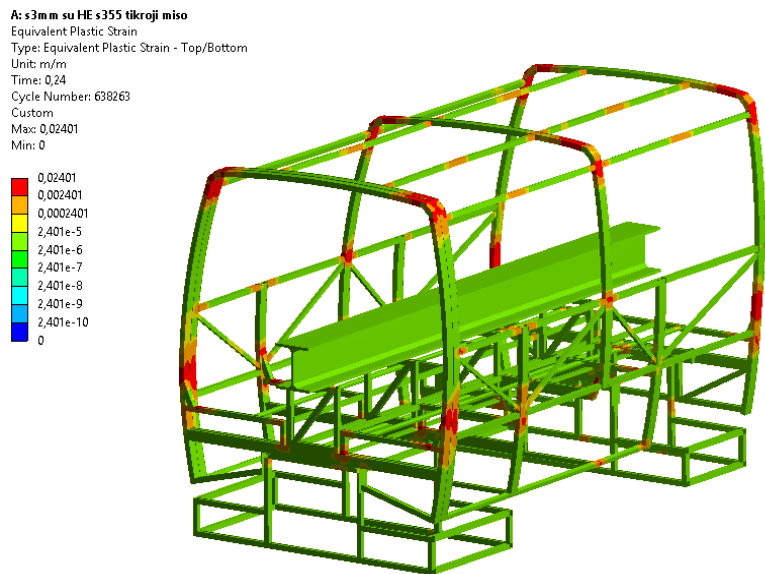
Figure 10. Fields of equivalent plastic deformations of the structure’s frame 0.24 s after the beginning of the impact, mm/mm.